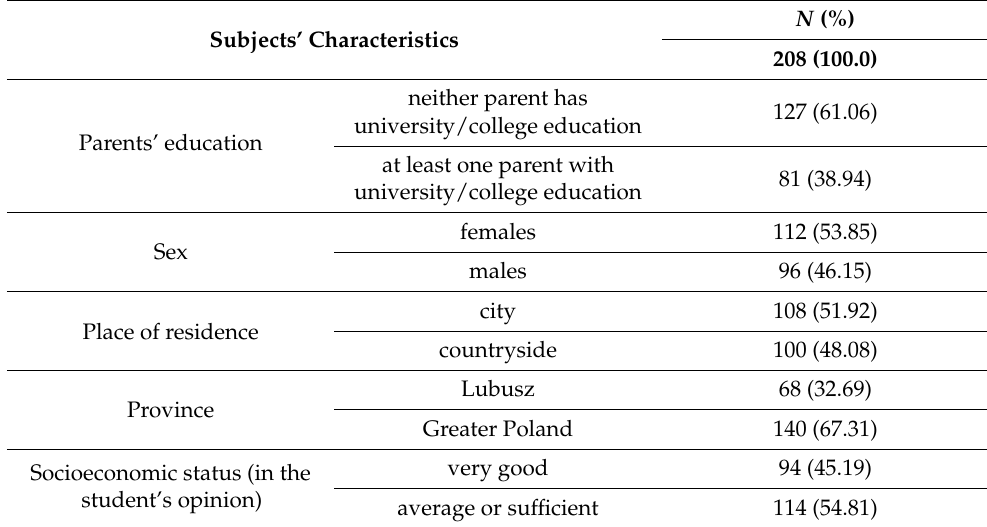
Table 2. The demographics of the study